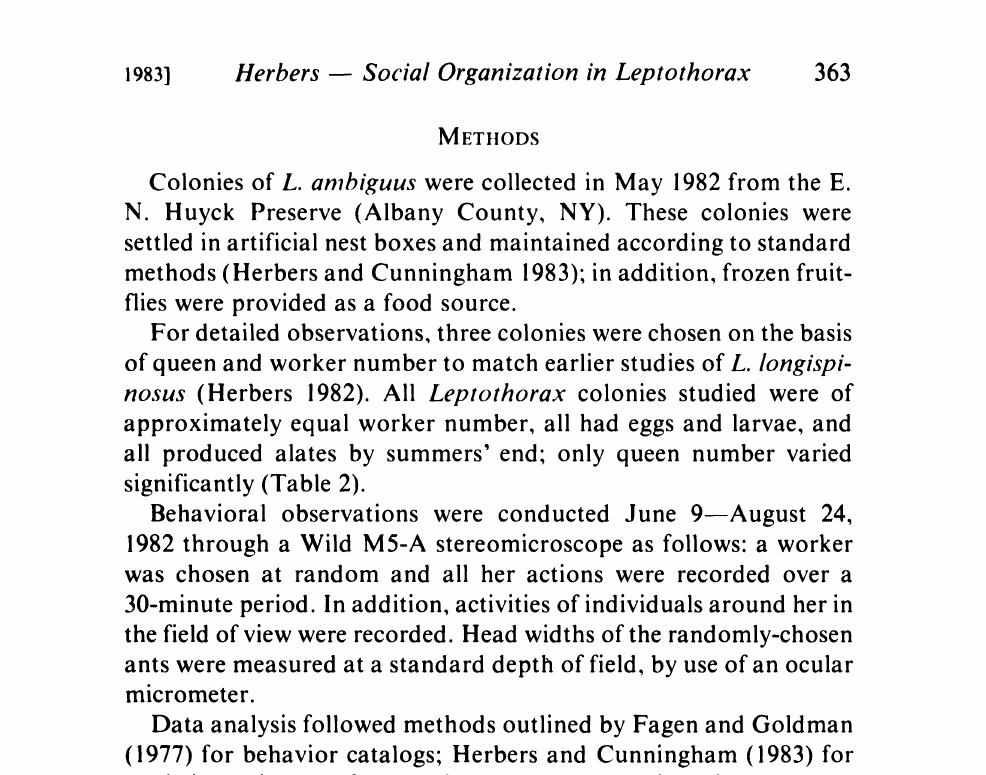
Table 2. Colony sizes of Leptothorax used in this comparative study. Data on L. hmgispinosus were reported by Herbers